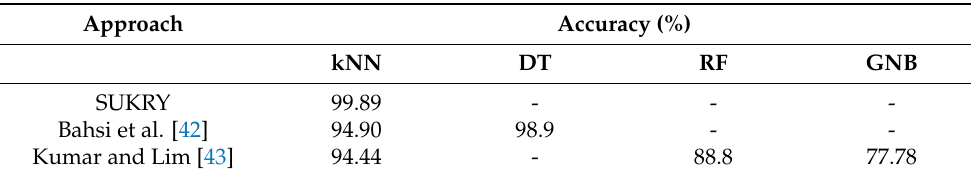
Table 7. Accuracy comparison with previous studies.